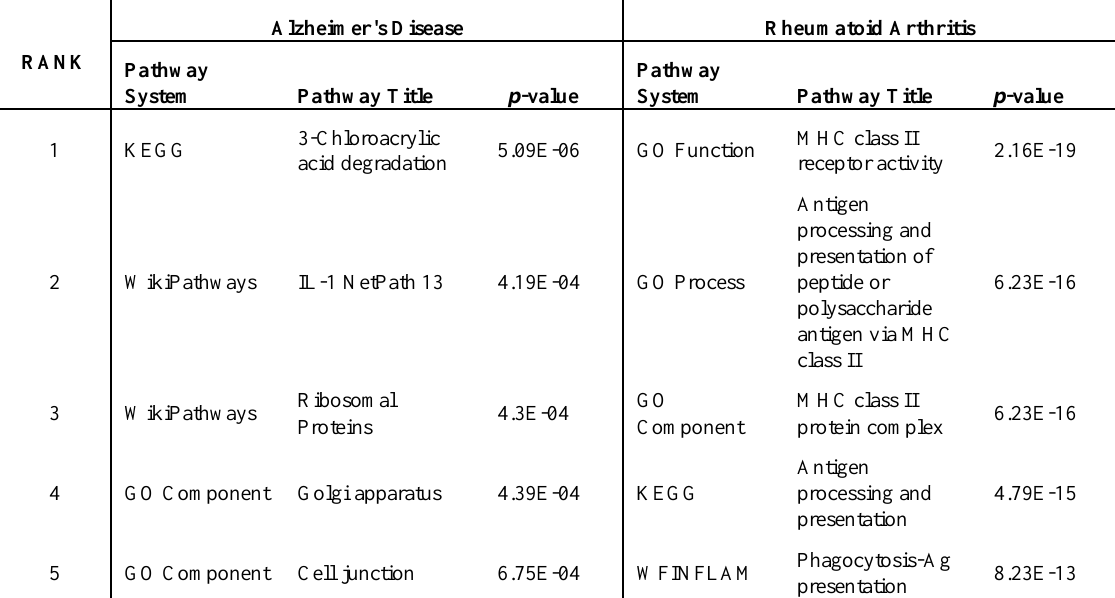
Table 11. Top 5 pathways with the lowest combined p-values. Given the p-value threshold of 0.05; 256 pathways are listed as significant for AD and 119 of them are listed as significant for RA.